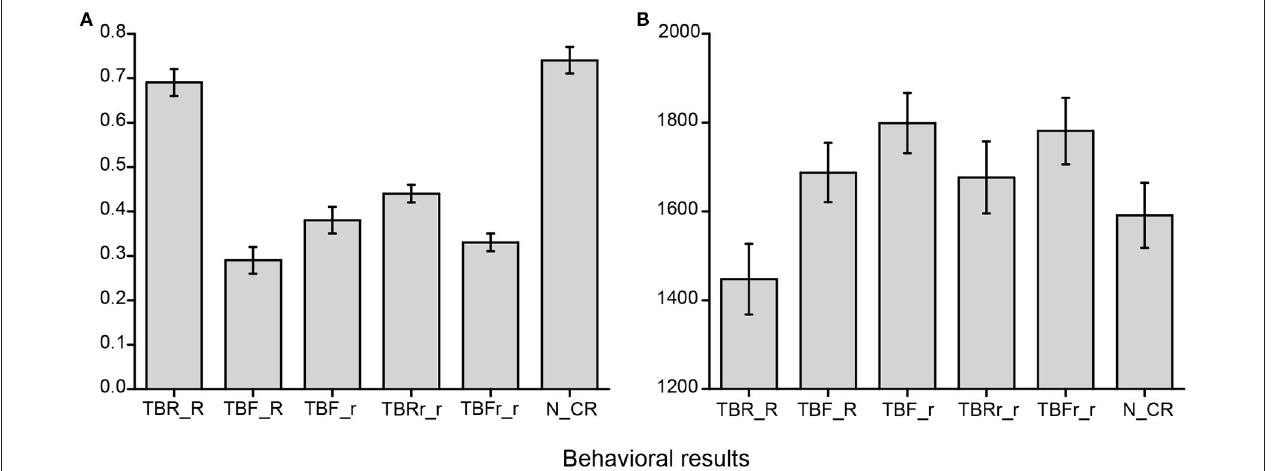
FIGURE 2 | Mean accuracy and Reaction times (RTs) in each condition. (A) Mean accuracy for selected conditions. (B) Mean RTs for selected